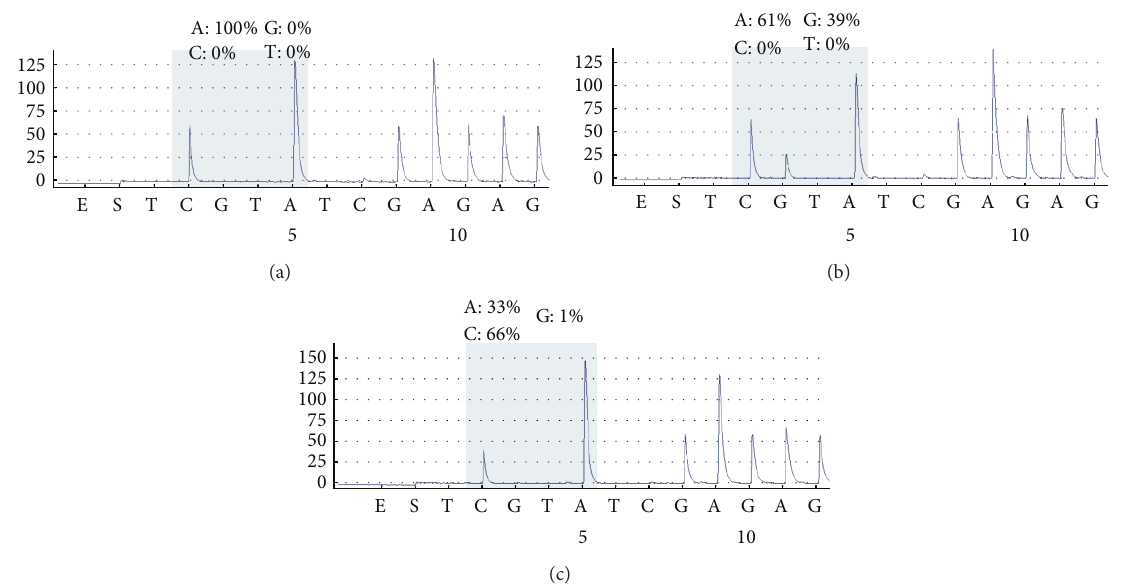
Figure 2: Analysis of NRAS mutation by pyrosequencing. Representative images of wild type (a), NRAS Q61R (c.182A > G) (b), and NRAS Q61K (c.181C > A)